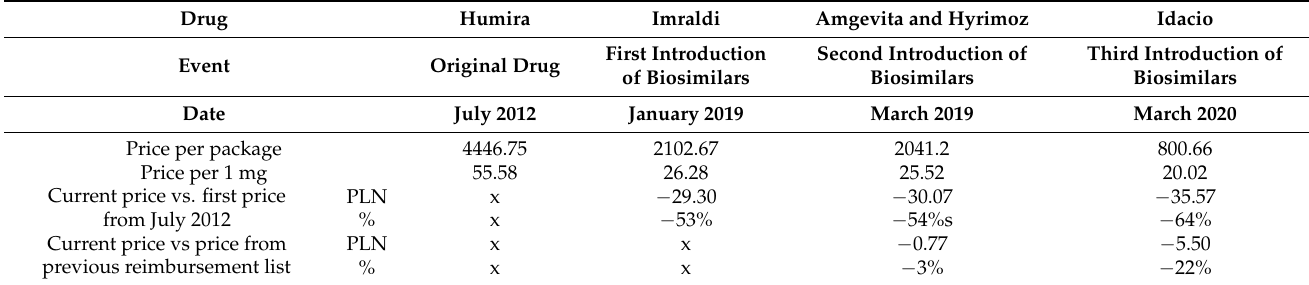
Table 2. Gross wholesale price changes between July 2012 and March 2020 of adalimumab after biosimilar reimbursement.